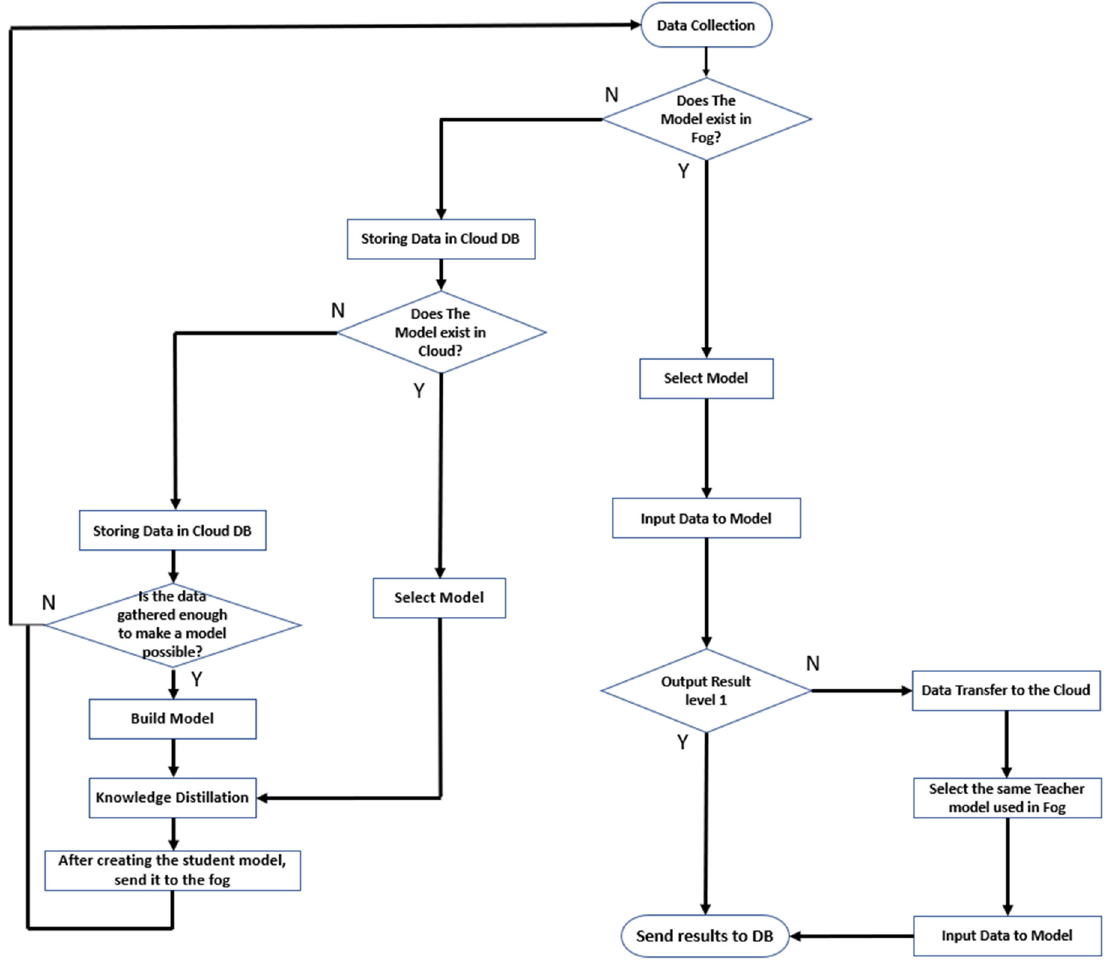
Figure 3. Information flow chart on interaction and collaboration relationship.